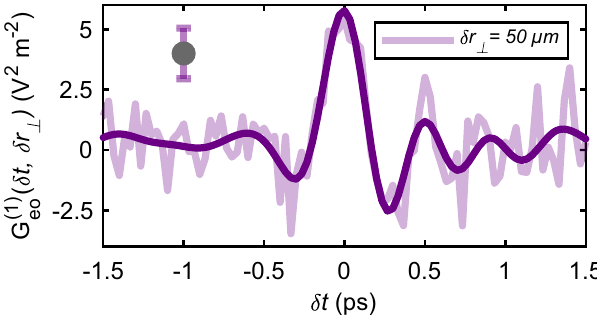
Fig. 2 Experimental measurement. The electro-optic electric fi eld correlation G ð 1 Þ eo ð δ t ; δ r Þ on the quantum vacuum is reported as a function of ? the temporal delay δ t between the laser pulses. The measurement (faded line) has been performed with an average spacing of δ r ⊥ = 50 μ m between the probing beams. For better visualization, a 3 THz low-pass fi lter has been applied to the experimental curve (thick line). The measurement presents a peak-to-peak amplitude of 7.5V 2 m − 2 and a temporal coherence of several picoseconds. The error bar indicates the 2 σ statistical con fi